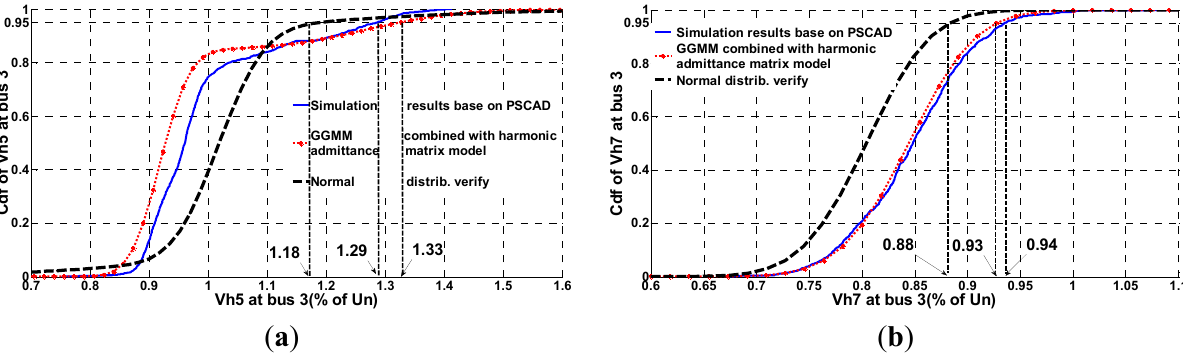
Figure 16. Cdfs of the harmonic voltages at bus 3 approximated by GGMM, Gaussian distribution and simulation results. ( a ) The fifth harmonic; ( b ) The seventh